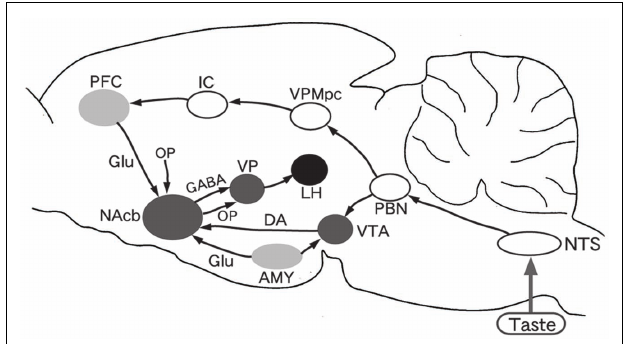
FIGURE 1 | Diagram of connections from the taste system to reward system and feeding center in the rat brain. NTS, nucleus of the tractus solitarius; PBN, parabrachial nucleus;VPMpc, parvocellular part of the ventralis posteromedial thalamic nucleus; IC, insular cortex; PFC, prefrontal cortex; AMY, amygdala;VTA, ventral tegmental area; NAcb, nucleus of accumbens;VP, ventral pallidum; LH, lateral hypothalamic area. DA, dopamine; GABA, γ -aminobutyric acid; Glu, glutamic acid; OP,